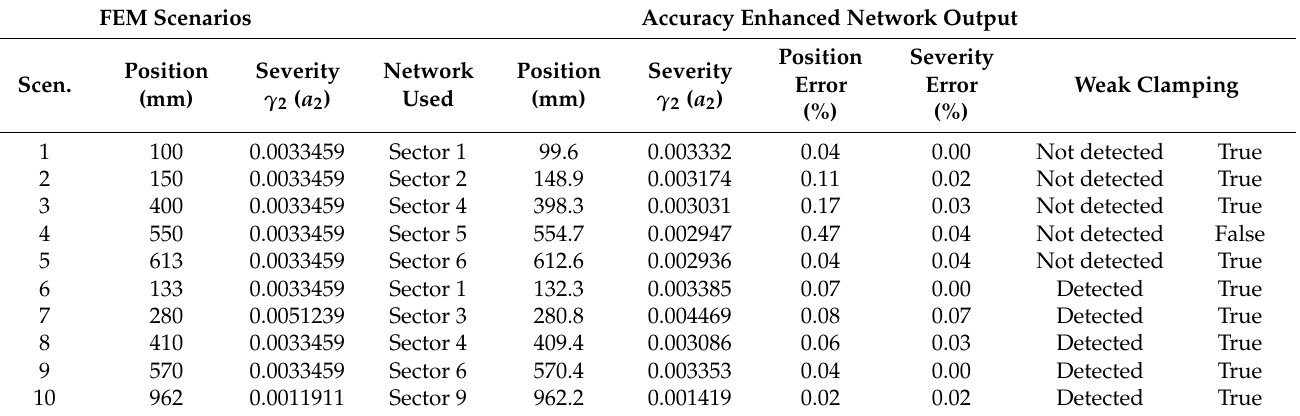
Table 8. Results obtained using the particular networks—fine